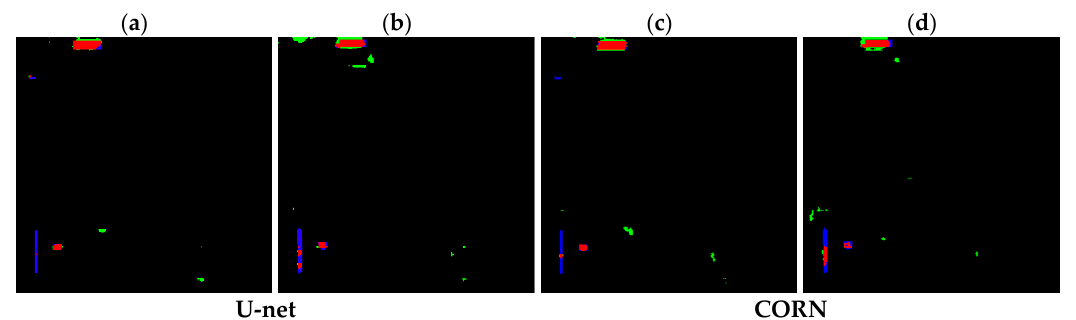
Figure 21. Comparison of the proposed model’s result and the ground truth of the Bangkok testing site: